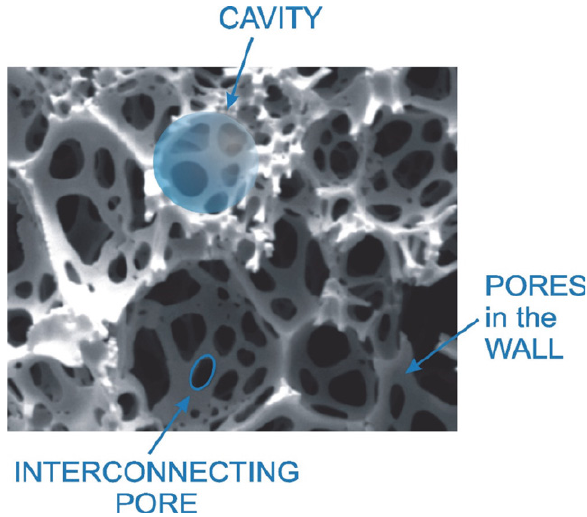
Figure 3 : PolyHIPE